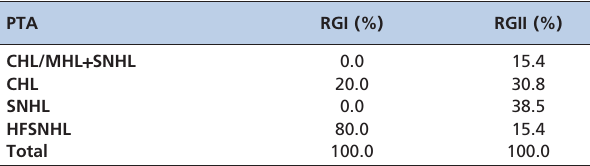
Table 5 - Proportions of types of hearing loss in Research Groups I and